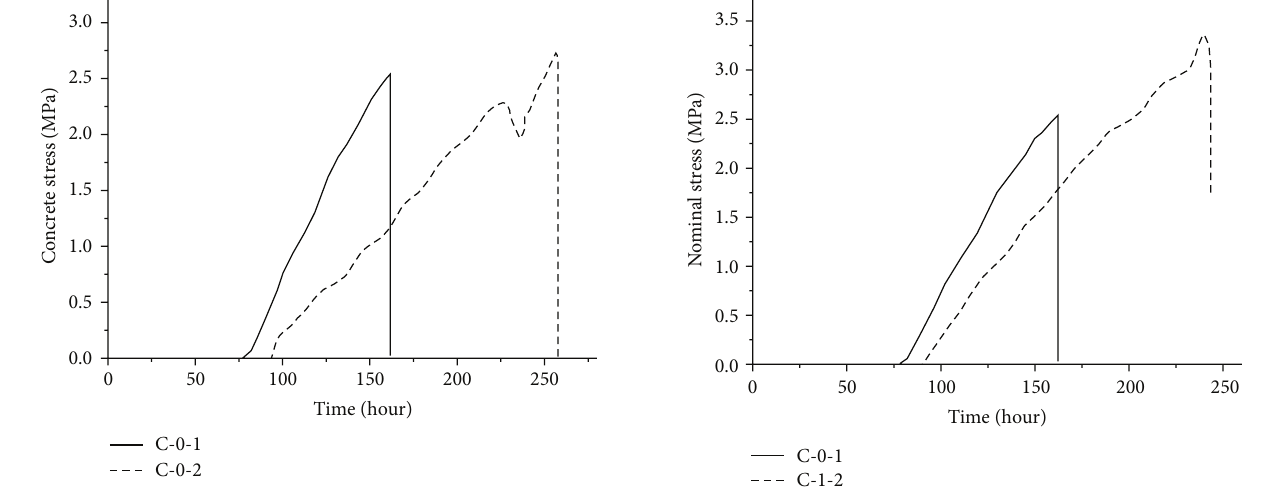
Figure 13: Nominal tensile stress of C-0-1 and